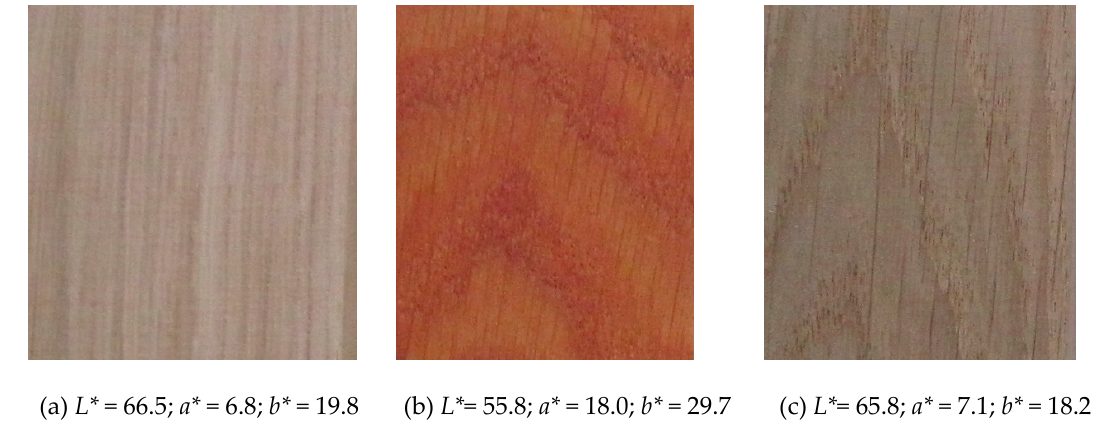
Figure 8. Photos of colour changes in oak wood ( a ) after application of surface treatment T1 with 3% concentration of nanoparticles TiO 2 ( b ); and additional colour change after 4 h of accelerated ageing ( c ).